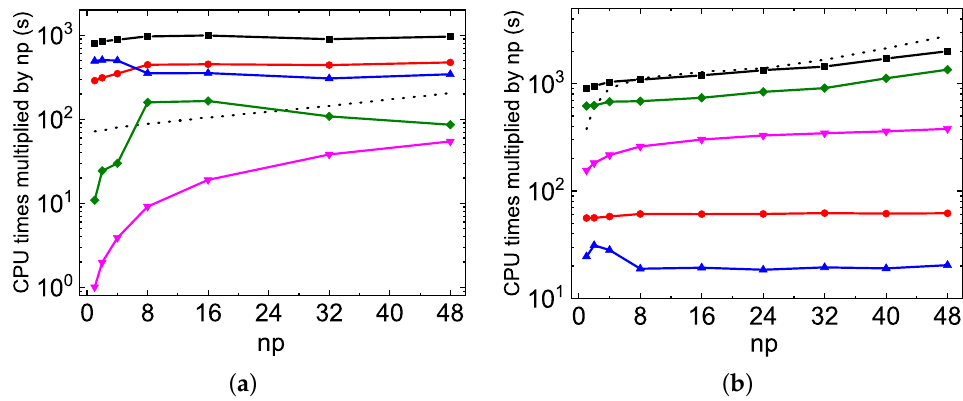
Figure 7. MPI performances for the partial and total CPU times for updating the orbitals in ( a ) Mg VII AS 5 and ( b ) Be I n = 15 calculations. Solid curves are the CPU times (in s) labeled “Update” (squares), “SetTVCof” (circles), “WithoutMCP” (up-triangles), “WithMCP” (down-triangles), and “SetLAG” (diamonds), respectively, for the first iteration of the rmcdhf_mpi_FD SCF calculations. (Some of them are also listed in Tables 3 and 5). In addition, the “NXA&NYA” CPU times are also shown as the dotted